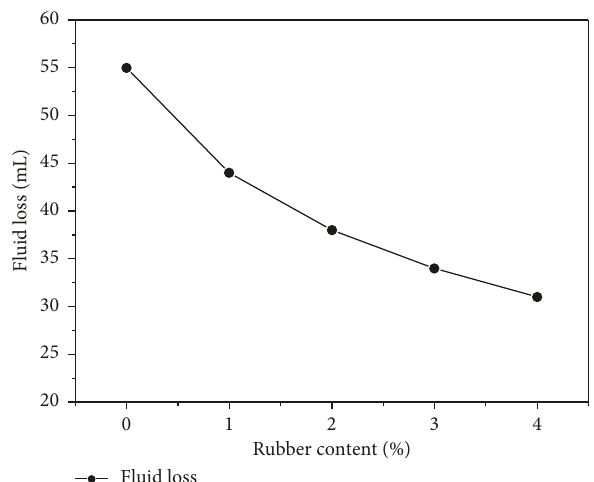
Figure 5: Dependence of rubber content on fluid loss of cement